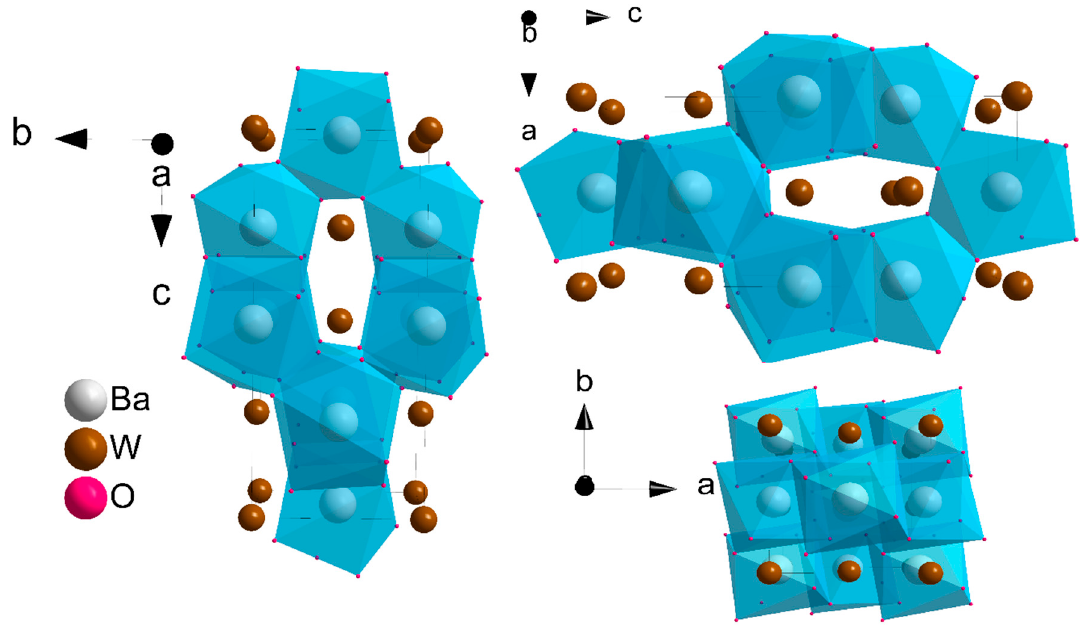
Figure 2. The structure of BaWO 4 in three directions [14].